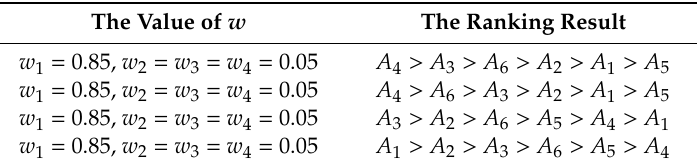
Table 4. The impact of criterion weight w on the ranking.